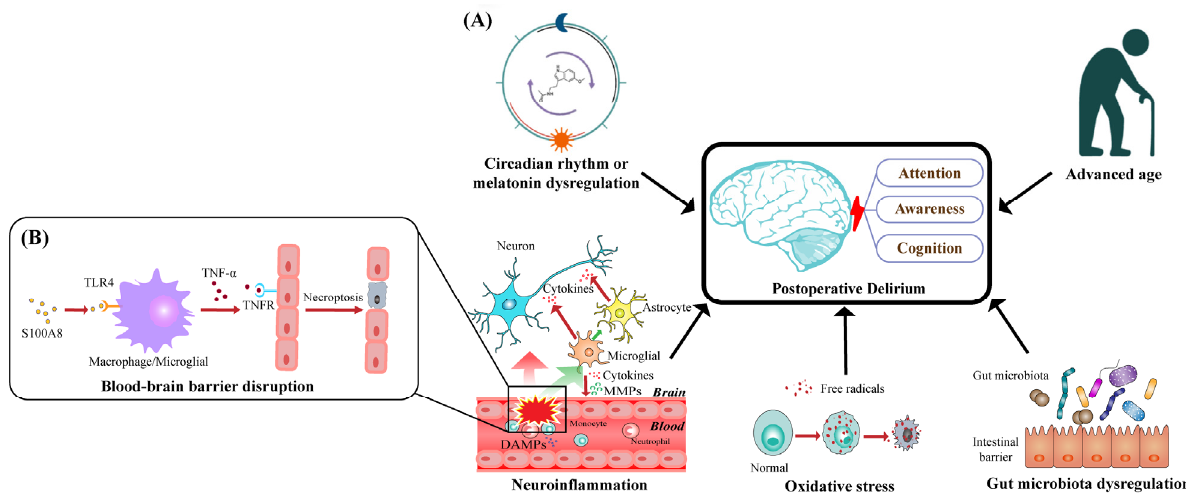
Figure 1. Schematic diagram of pathological mechanisms underlying postoperative delirium: ( A ) five dominant pathological theories that may account for the occurrence and development of POD characterized by disturbances in attention, awareness, and cognition; ( B ) S100A8, as a main member of DAMPs, promotes the activation of TLR4 in macrophages and microglia and then increases the expression of TNF- α ; TNF- α will bind to TNFR on endothelial cells, subsequently triggering their necroptosis, which disrupts BBB’s integrity and increases BBB’s